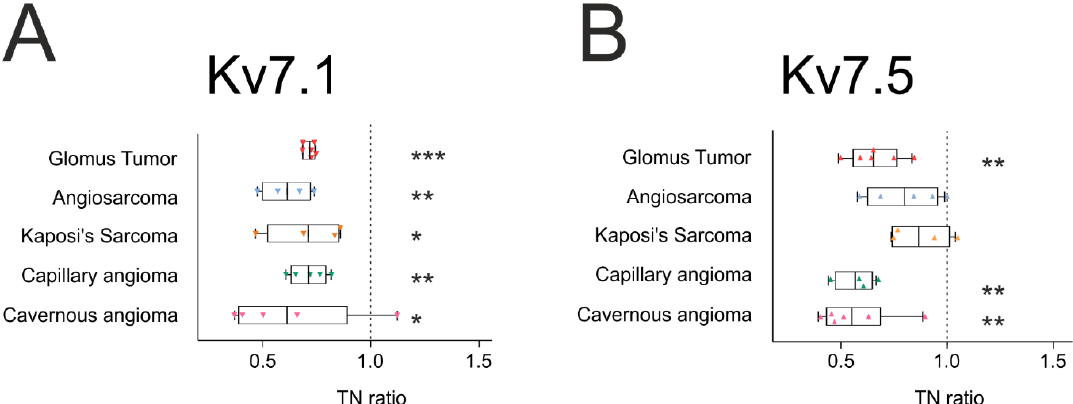
Figure 3. Tumor-to-normal (TN) Kv7.1 and Kv7.5 ratios. TN ratios were calculated as described in the Materials and Methods from protein expression levels in immunofluorescence assays, and the data are represented in a box-and-whisker plot. The analysis was performed for Kv7.1 ( A ) and Kv7.5 ( B ). The reference value (1) is indicated by a dotted vertical line. Boxes represent the interquartile range (IQR: 25–75%) of the values. The inside-box line represents the mean of each group. Minimum and maximum values are indicated outside the box. Cavernous angioma, in magenta; Capillary angioma, in green; Kaposi’s sarcoma, in orange; Angiosarcoma, in blue; Glomus tumor, in red. * p < 0.05, ** p < 0.01 and *** p < 0.001 vs. reference value (one sample t -test statistics).